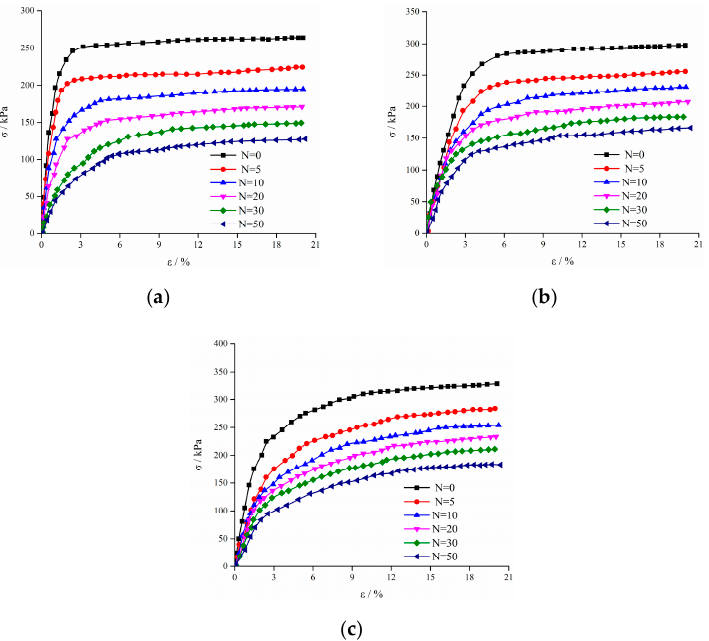
Figure 6. Stress–strain curves under different confining pressures under freeze–thaw cycles. ( a ) σ 3 = 200 kPa, ( b ) σ 3 = 300 kPa, ( b ) σ 3 = 300 kPa, ( c ) σ 3 = 400 kPa.